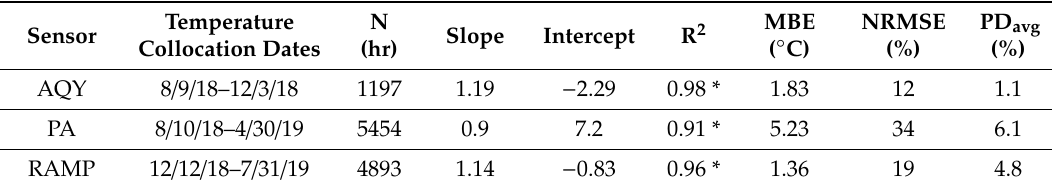
Table 2. Average temperature linear regression parameters a for 2 sensors of each type at AIRS during ambient monitoring.